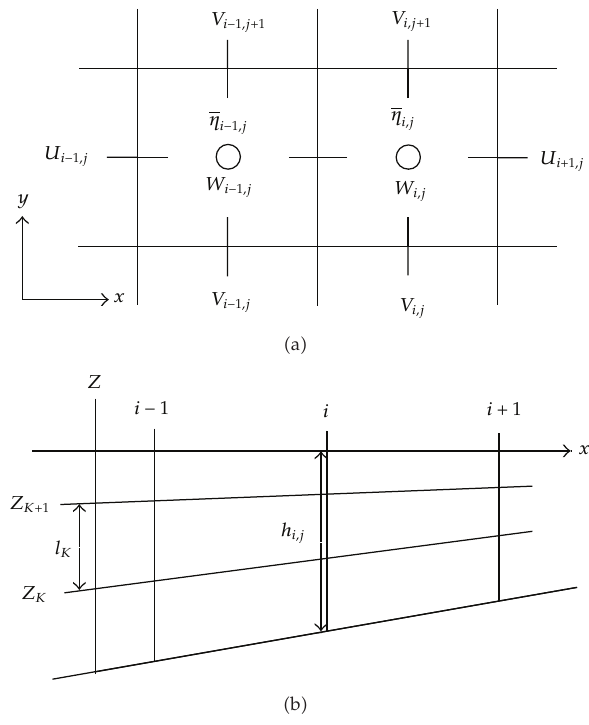
Figure 2: Arrangement of variables in WINCM.